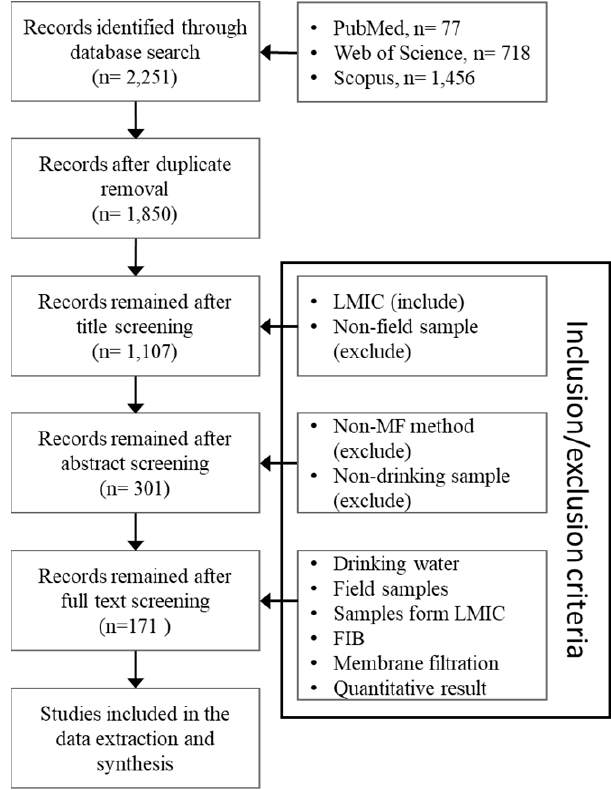
Figure 2. Results of the systematic review screening steps. Table 1. Literature review results on reporting the sample collection, analysis, and processing. BDL, below detection limit; ADL, above detection